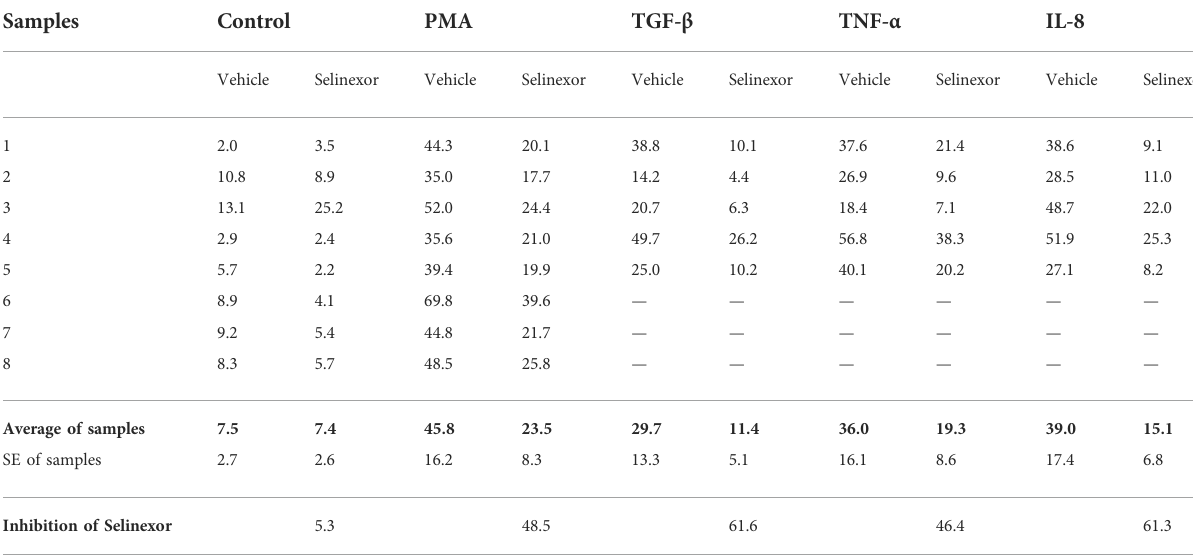
50 nM of selinexor or vehicle for 2 h prior to measurement of enzymatic activities. None of the enzymatic activities of NE, MPO and PAD4 were signi fi cantly in fl uenced by 2 h-selinexor TABLE 1 NETs release induced by different inducers used in our study and the effect of Selinexor on NETs release. NETs release %